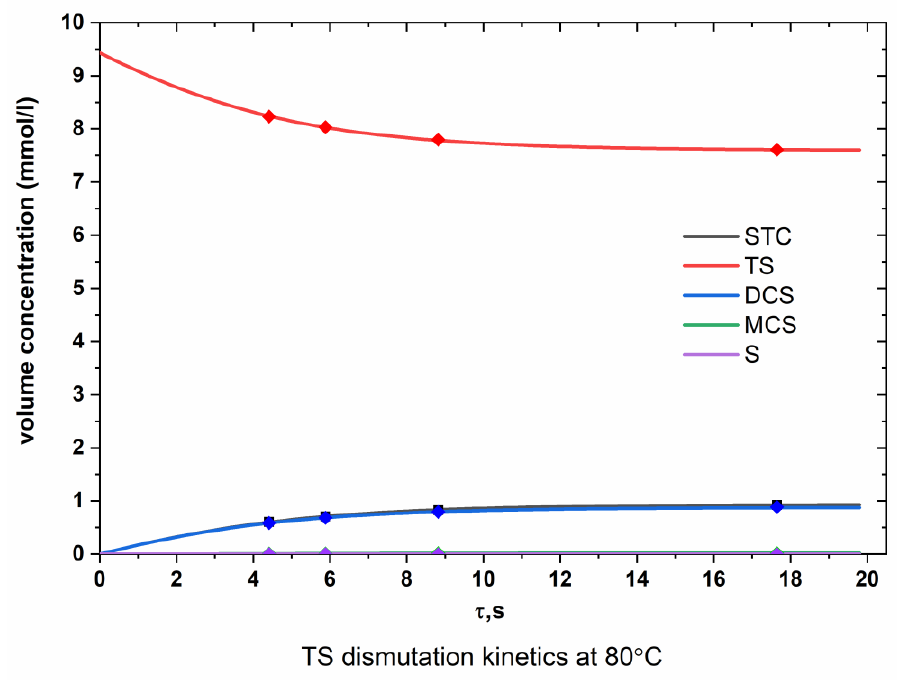
Figure A1. Dependence of the molar concentrations of chlorosilanes on time (TS, 80 °C).